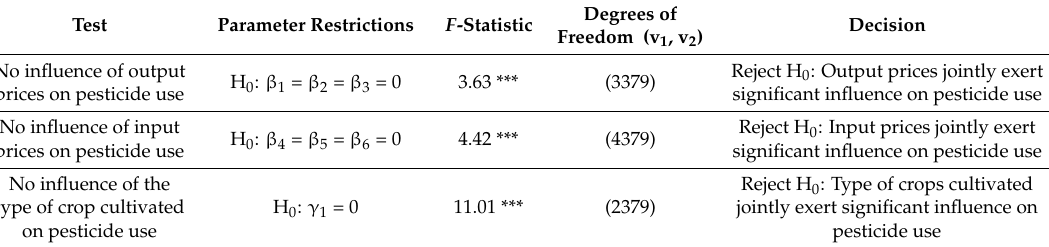
Table 5. Hypothesis